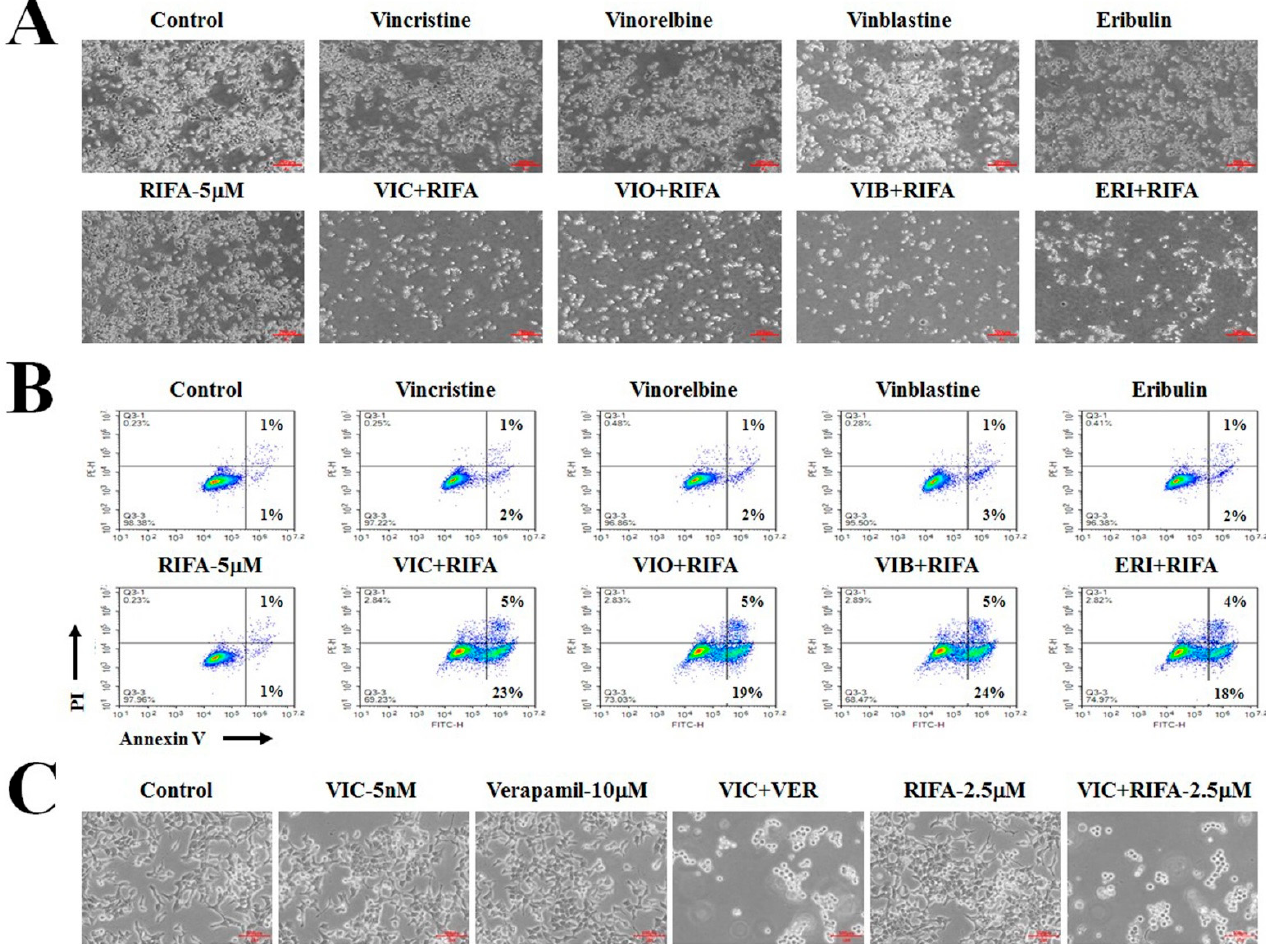
Figure 4. Rifabutin increases cytotoxicity of other antimitotic drugs to KBV20C cells. ( A , B ) KBV20C cells were treated with 5 nM vincristine, 0.1 μ g/mL vinorelbine, 5 nM vinblastine, and 30 nM eribulin alone or in combination with 5 μ M rifabutin (RIFA) or 0.1% DMSO (Control). After 24 h, all cells were observed using an inverted microscope at x40 magnification ( A ) or subjected to annexin V analyses ( B ). ( C ) KBV20C cells were treated with 5 nM VIC, 2.5 μ M rifabutin, 10 μ M verapamil, 5 nM VIC with 10 μ M verapamil (VIC+VER), 5 nM VIC with 2.5 μ M rifabutin (VIC+RIFA), or 0.1% DMSO (Control). After 1 day, all cells were observed using an inverted microscope at ×100 magni- fication.